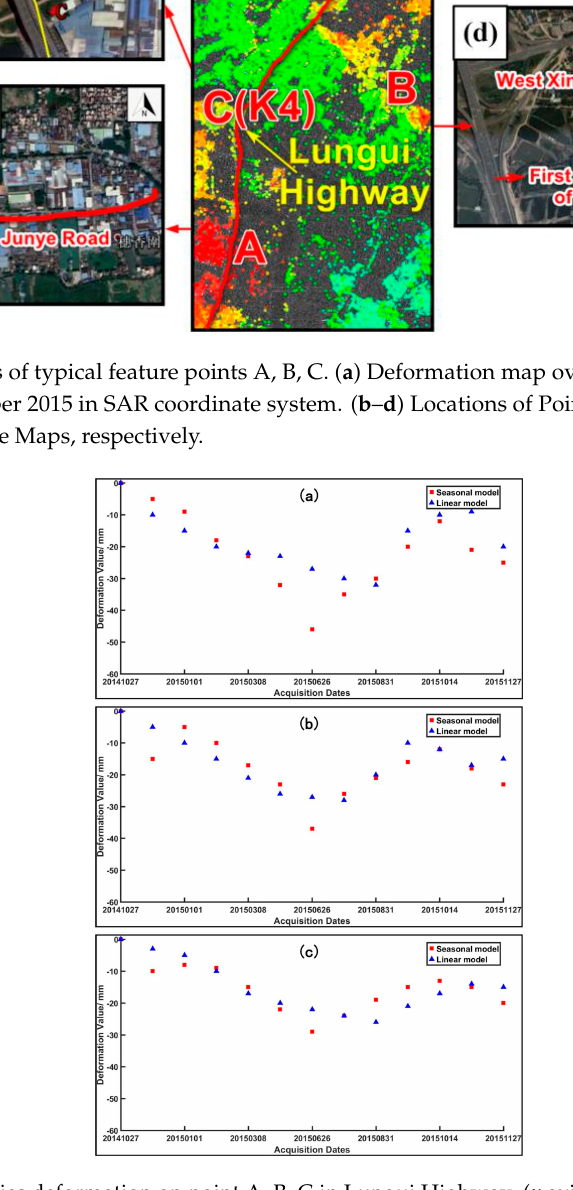
Figure 10. Time series deformation on point A, B, C in Lungui Highway. ( x axis defines the acquisition data of TerraSAR-X images, y axis defines the deformation values) ( a ) Point A; ( b ) Point B; ( c ) Point C (K4).